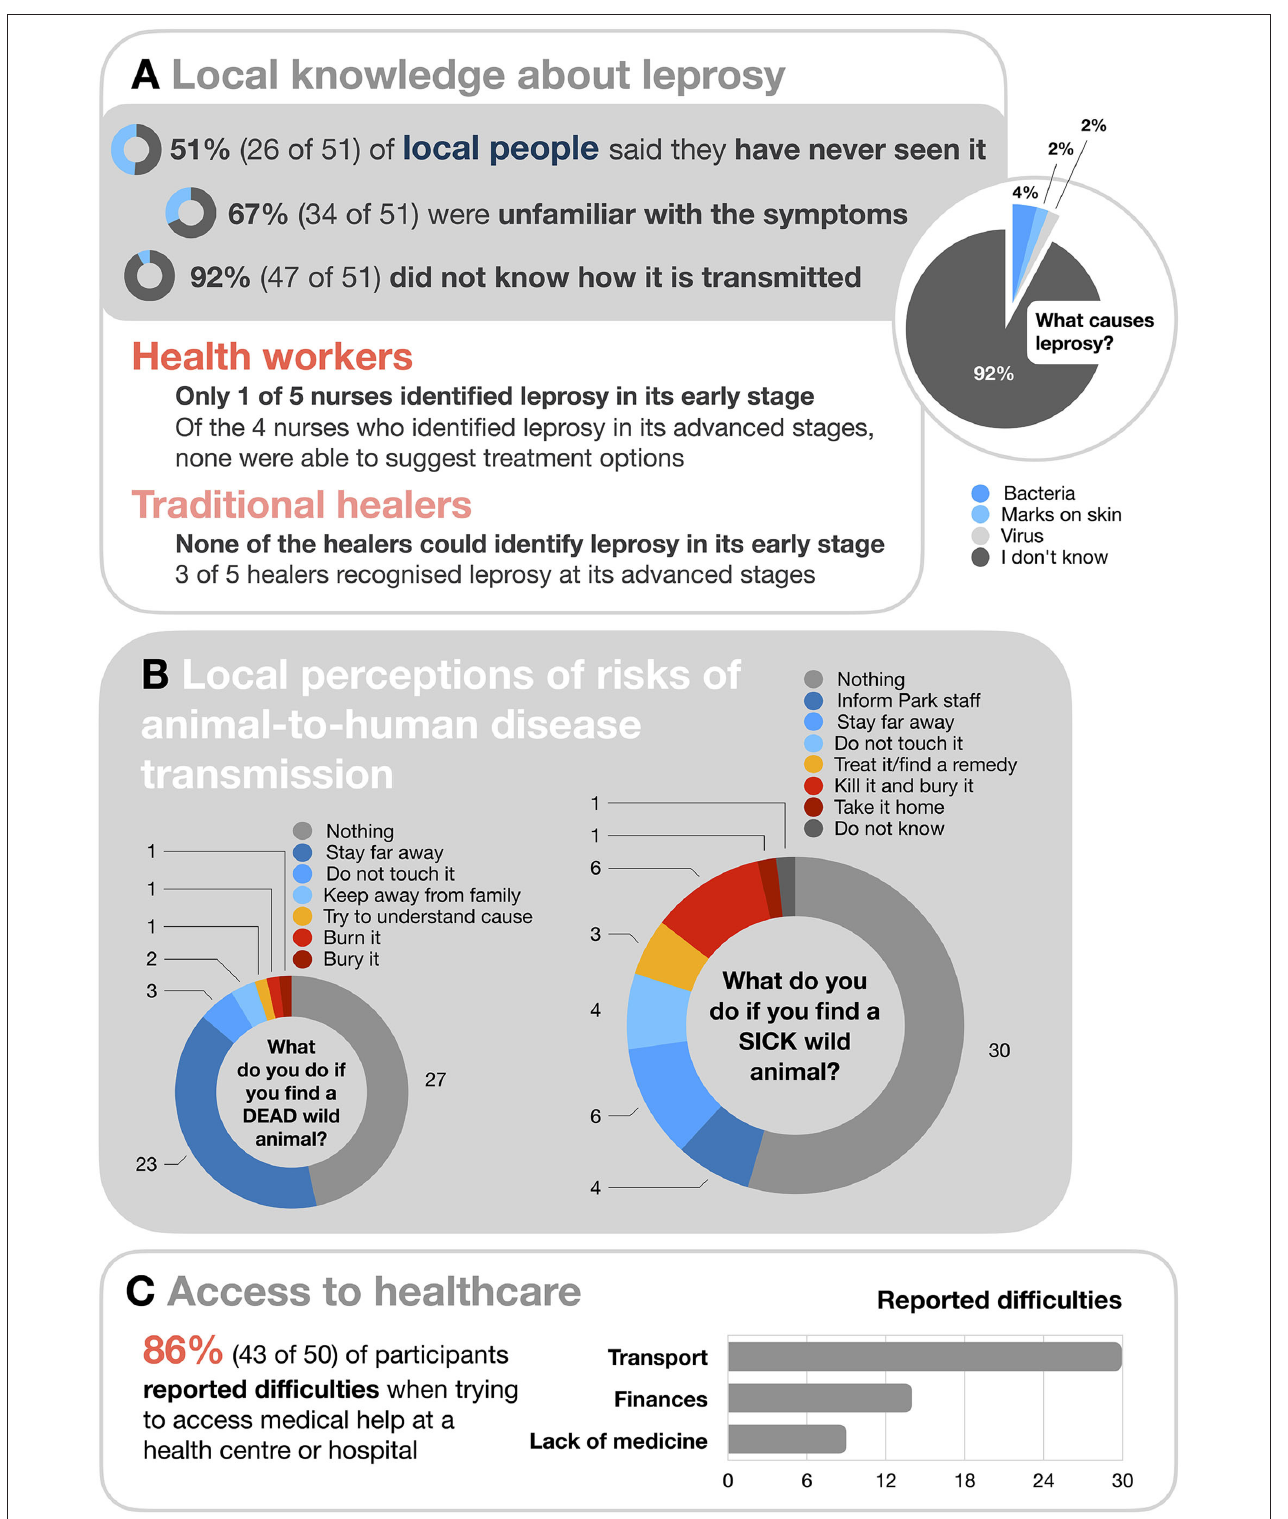
FIGURE 4 | Summary of results from interviews conducted across 27 villages in Cantanhez NP, to (A) understand local knowledge of disease including leprosy (51 household participants, five health workers and five traditional healers); (B) local perceptions of disease transmission risks (50 household participants); and (C) reported problems when attempting to access health care in Cantanhez NP (50 household participants). Values in sections